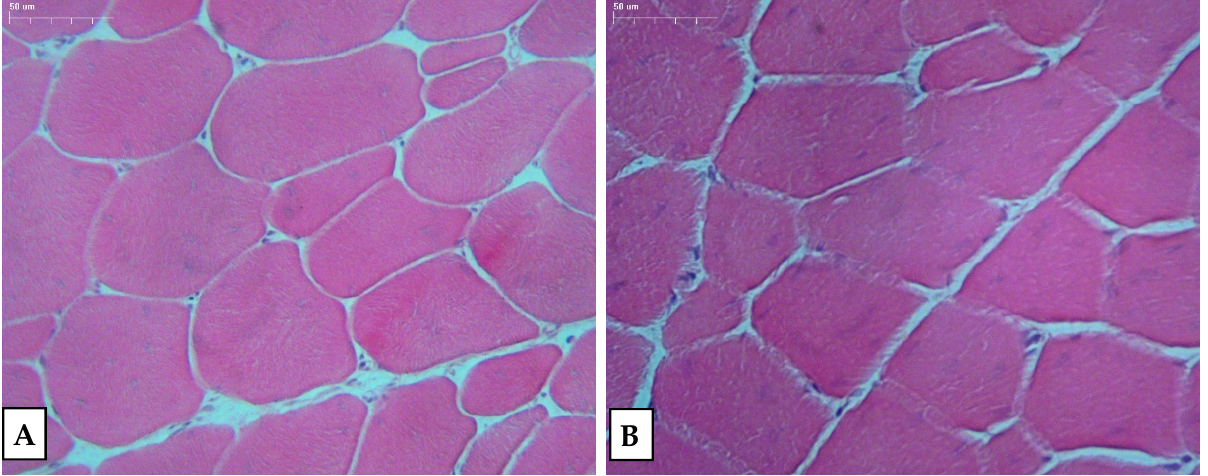
Figure 1. Microscopic picture of pectoral muscle of ( A ) male and ( B ) female organically reared Ross 308 broiler chickens, hematoxylin and eosin (H&E) staining, magnification: 200 × . The smaller thickness of the fibers beneficially affects the meat quality and might be considered an indicator of fibrillarity and a delicate structure of the meat [40]. Berri et al. [51] also confirmed the significant effect of sex on most of the analyzed characteristics, including the fiber diameter. The greater diameter of the muscle fibers in the female birds was associ- ated with a higher plasma creatine kinase activity, i.e., a factor influencing muscle growth, which differentiated both sexes [51]. The content of total collagen and soluble collagen and other parameters were similar ( p > 0.05) between the sexes. The collagen content was lower in the female birds, but the differences were not statistically significant. A similar trend was noted by Tavaniello et al. [52] in quails, whose collagen content was significantly lower in females, and this could be related to differences in the hormone metabolism between male and female birds [52]. Collagen content is an important parameter influencing